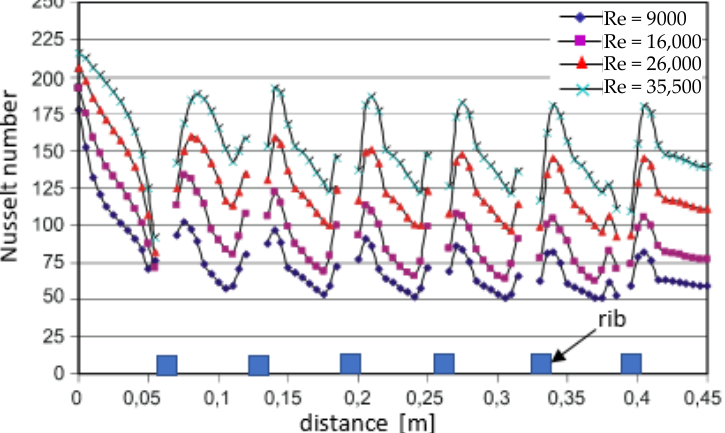
Figure 17. Local Nusselt number distribution for different Re numbers for a channel with perpendicular ribs on the bottom surface of the channel (configuration_1).